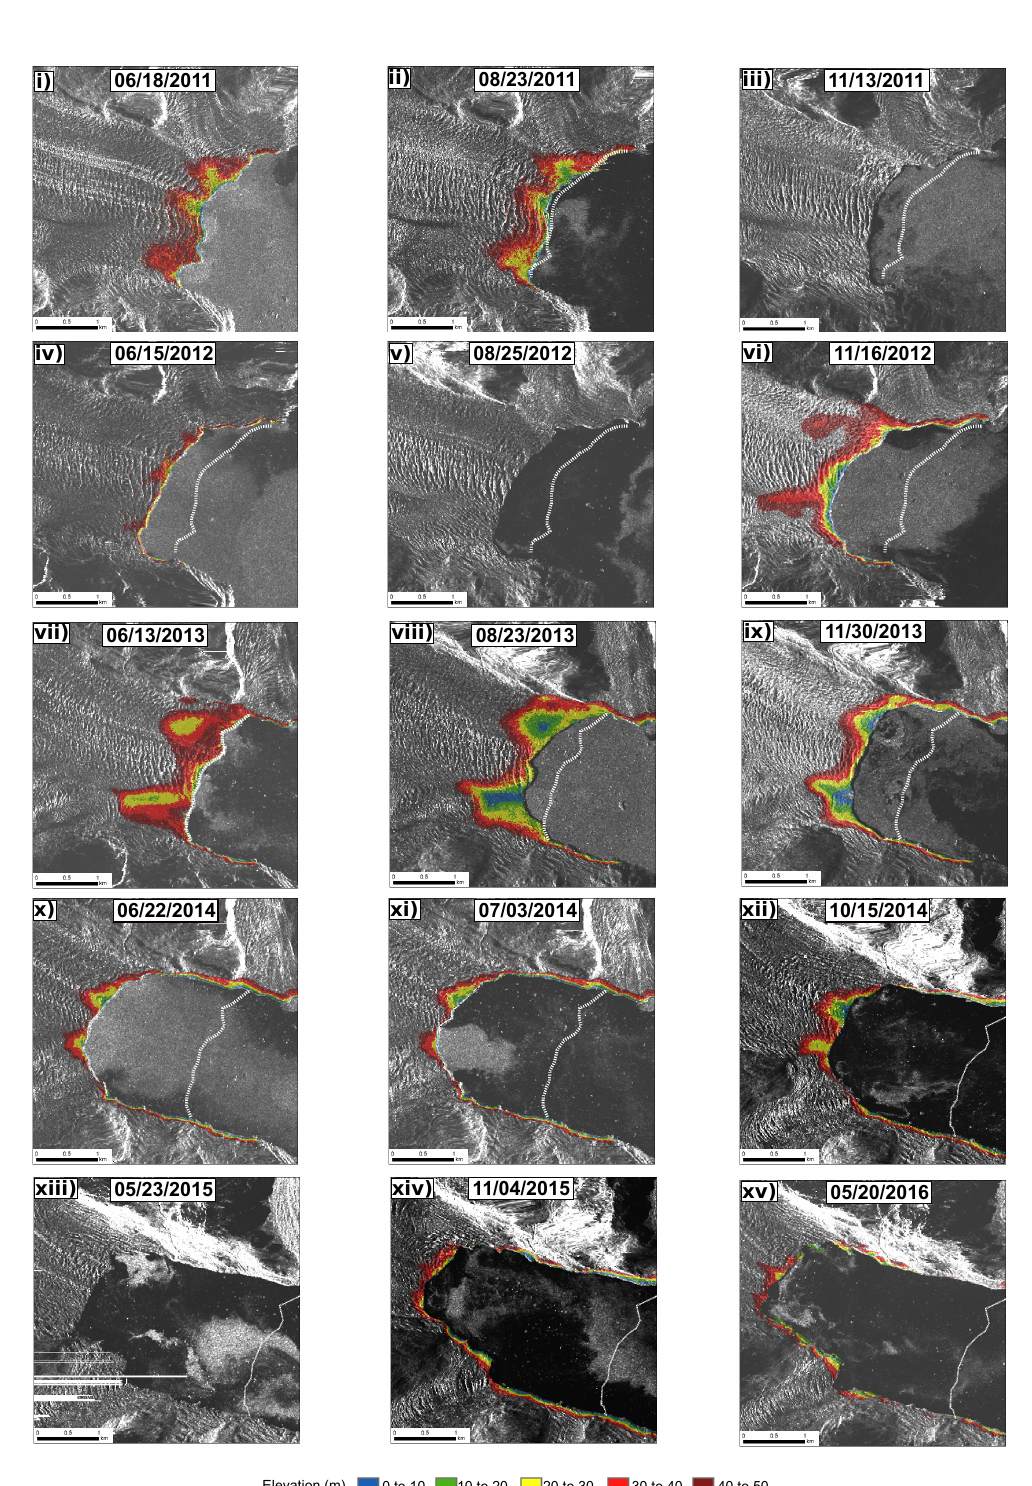
Figure 6. The colors indicate the surface elevation (H f in Equation (7)), above the sea surface, of the west branch, ranging from 0 to 50 m, on the respective dates. The dates are mentioned on the top of each panel. The white line from ( i – vi ) and ( vii – xv ) represents the front position of the west branch on 06/18/2011 and 06/13/2013